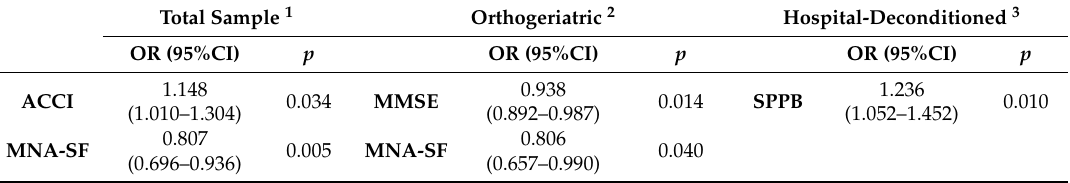
Table 6. Logistic multivariate regression model of falling during